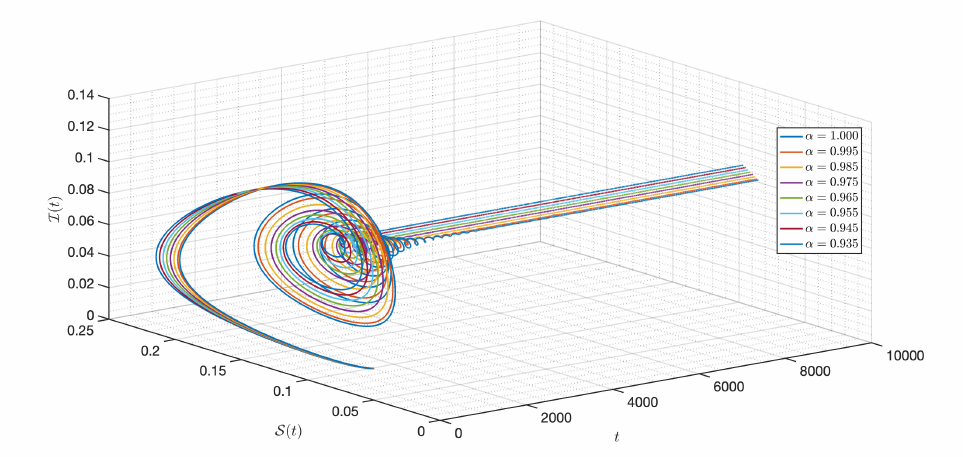
Figure 31. Dynamic of the model (3) for different parameters in Case III